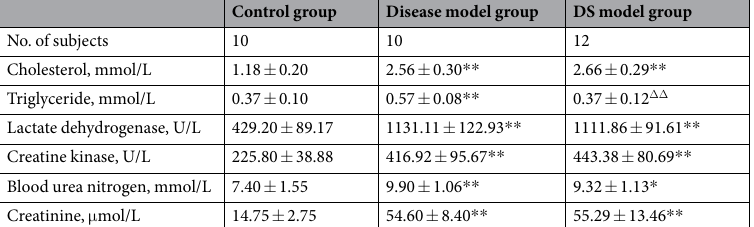
Table 1. Comparison of serum biochemistry analysis among groups a, b . a The serum levels of biochemical indices of rats are presented as the mean ± standard deviation. b The serum concentrations of biochemical indices were statistically tested by Dunnett’s t -test when the variance in different groups was homogeneous and by the Games-Howell test when the variance was non-homogeneous. * P < 0.05, ** P < 0.01 compared with the control group; Δ P < 0.05, ΔΔ P < 0.01 compared with the disease model group.